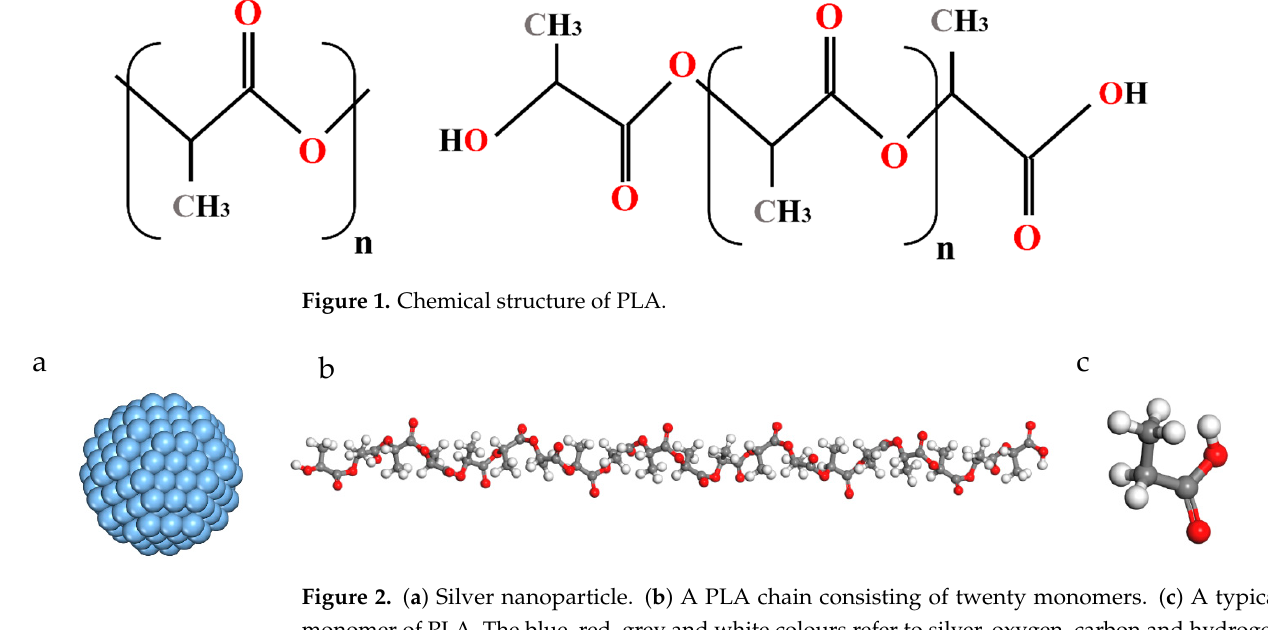
Figure 2. ( a ) Silver nanoparticle. ( b ) A PLA chain consisting of twenty monomers. ( c ) A typical monomer of PLA. The blue, red, grey and white colours refer to silver, oxygen, carbon and hydrogen atoms, respectively.